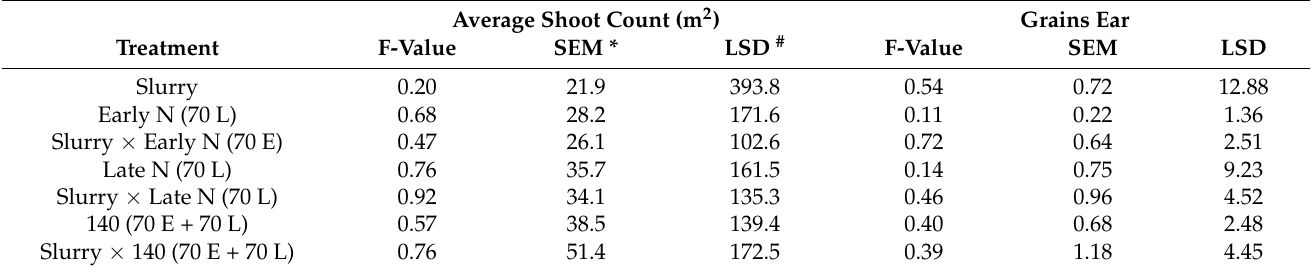
Table A3. 2017/18 ANOVA analysis of shoot count and grains/ear. Table A3 2017/18 ANOVA analysis of shoot count and grains/ear.